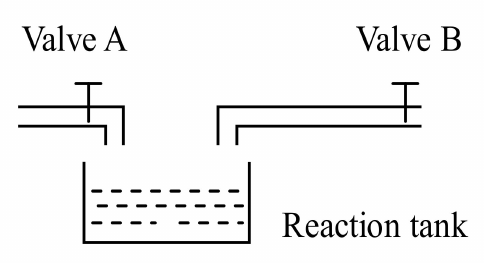
Figure 5. System with Different Driving Units.